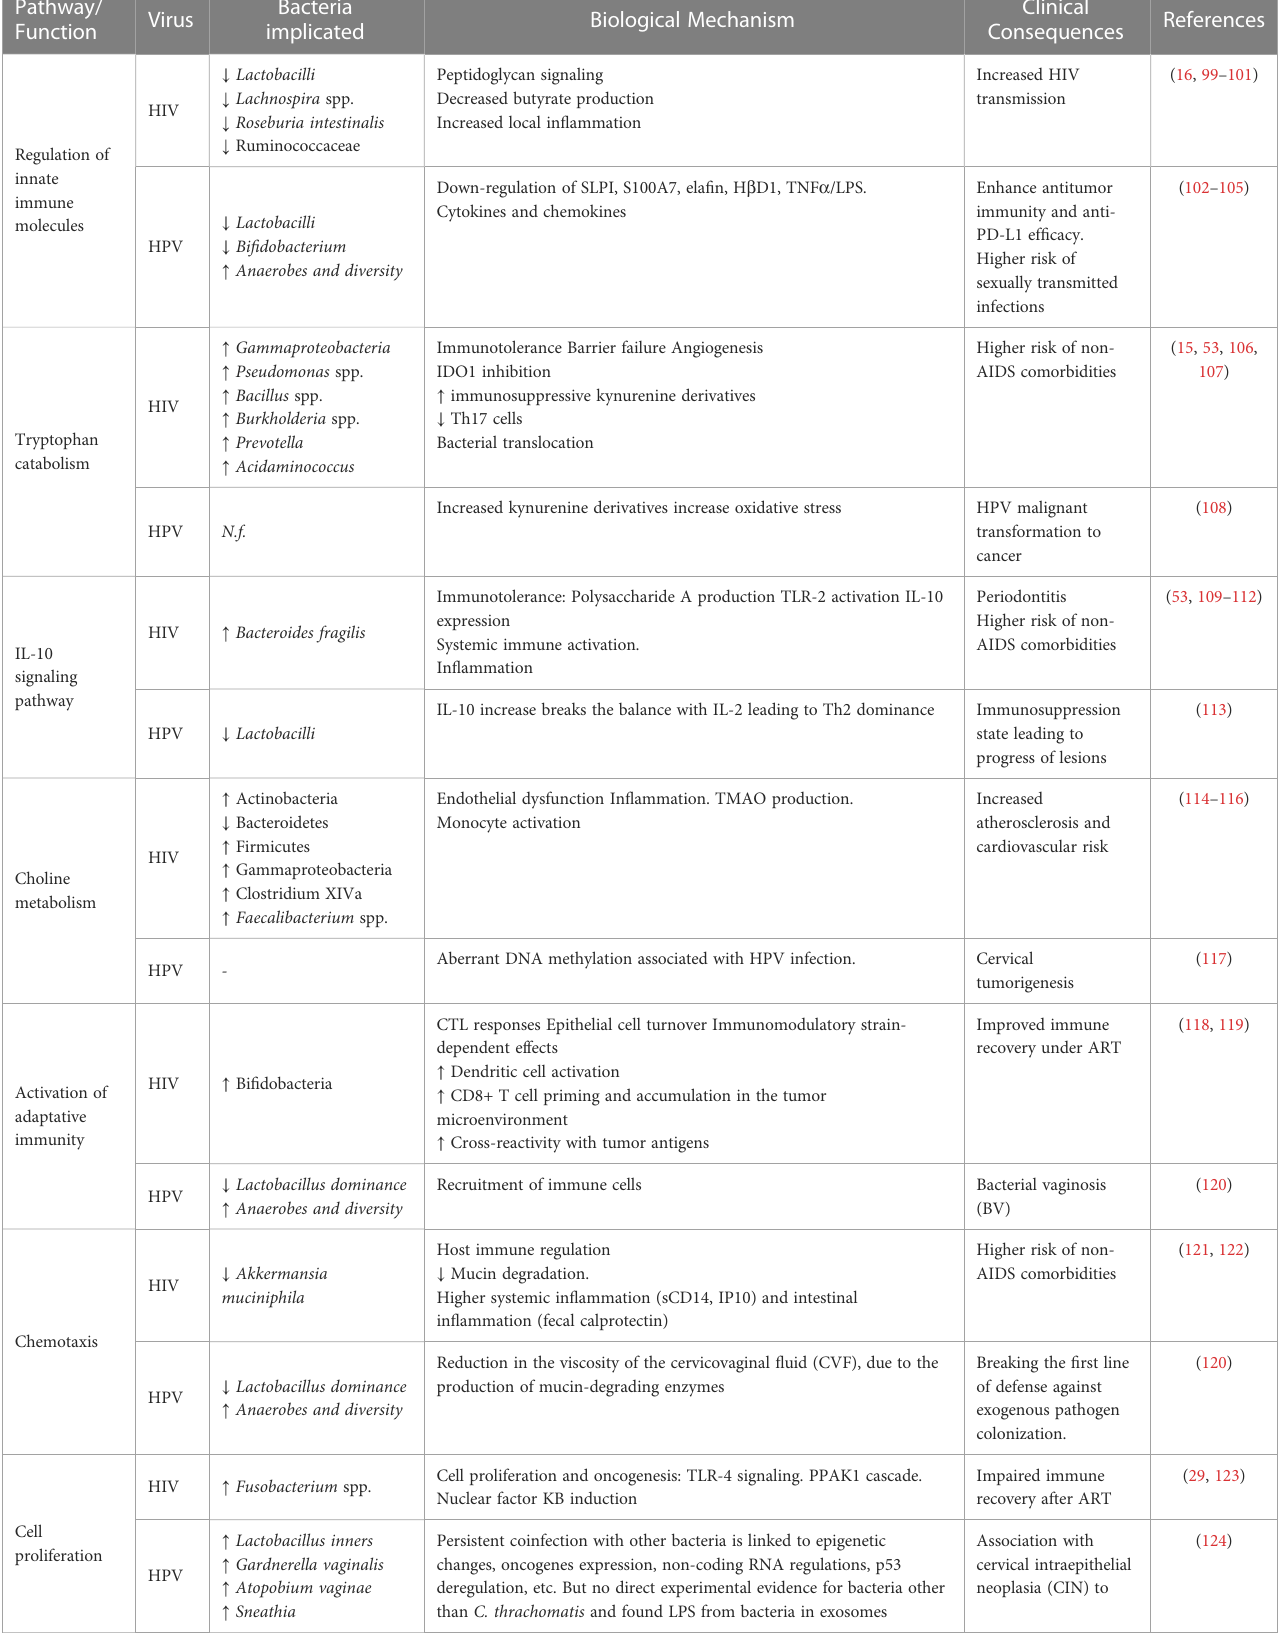
TABLE 1 Summary of the major mechanisms by which the microbiota in fl uences HIV and HPV infection. Pathway/